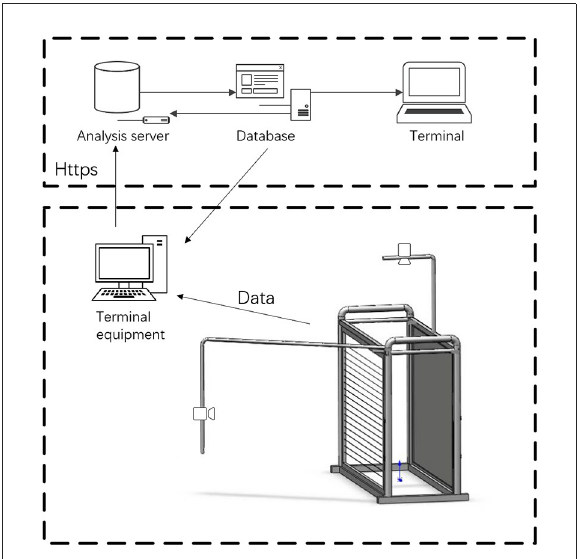
FIGURE1 Body size and weight data collection channel. BW, body weight; HW, height at wither; BSL, body slanting length; CD, chest depth; CC, chest circumference; SC, shank circumference; HH, hip height; SW, shoulder width; RW, pump